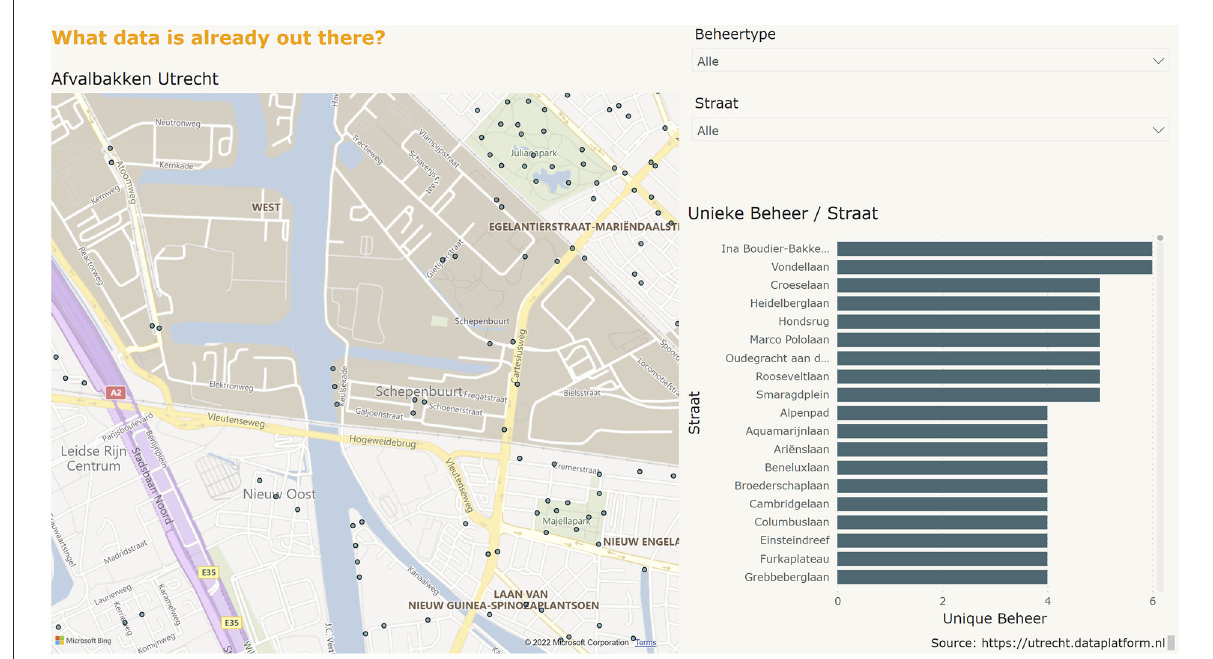
FIGURE5 The low density of public bins in the area. The visualization was done by Ruth Schmidt with the publicly available data from the municipality of Utrecht.